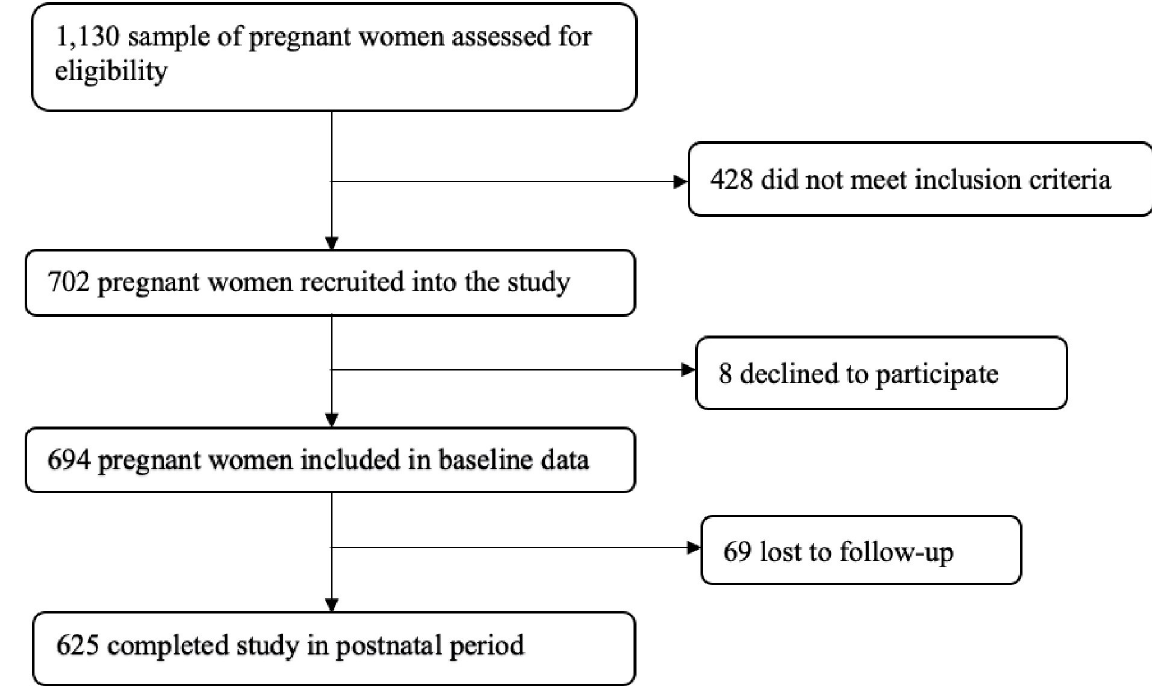
Fig 1. Flowchart for recruitment and follow-up of